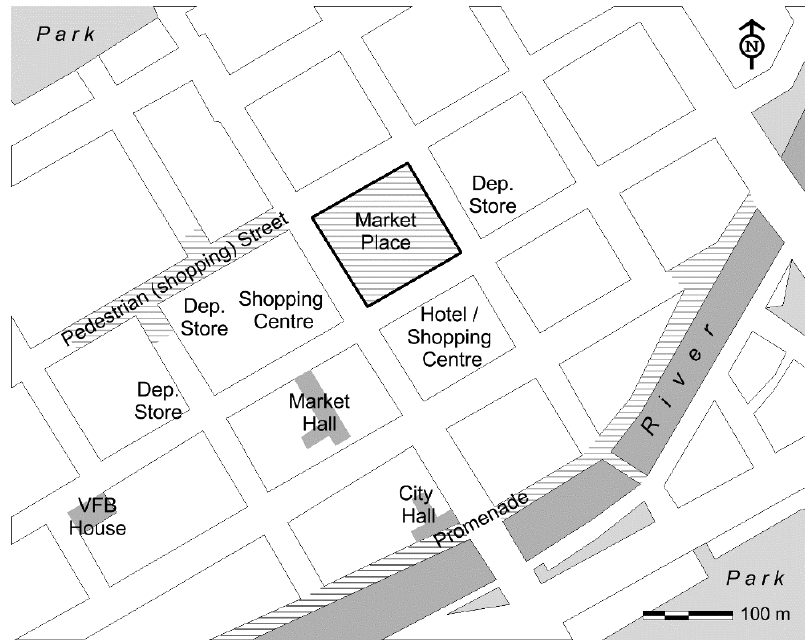
Figure 3. The Turku city-centre shopping environment with places of